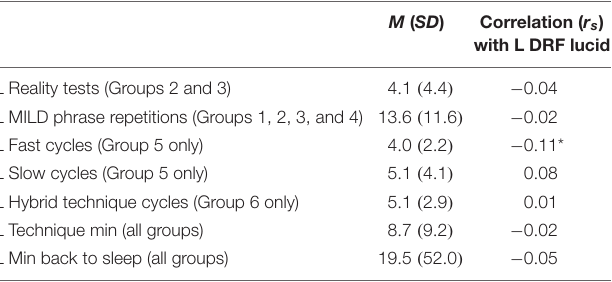
TABLE 5 | Spearman rho non-parametric correlations between Week 2 lucid dreaming rates and variables that operationalize the way in which the lucid dream induction techniques were